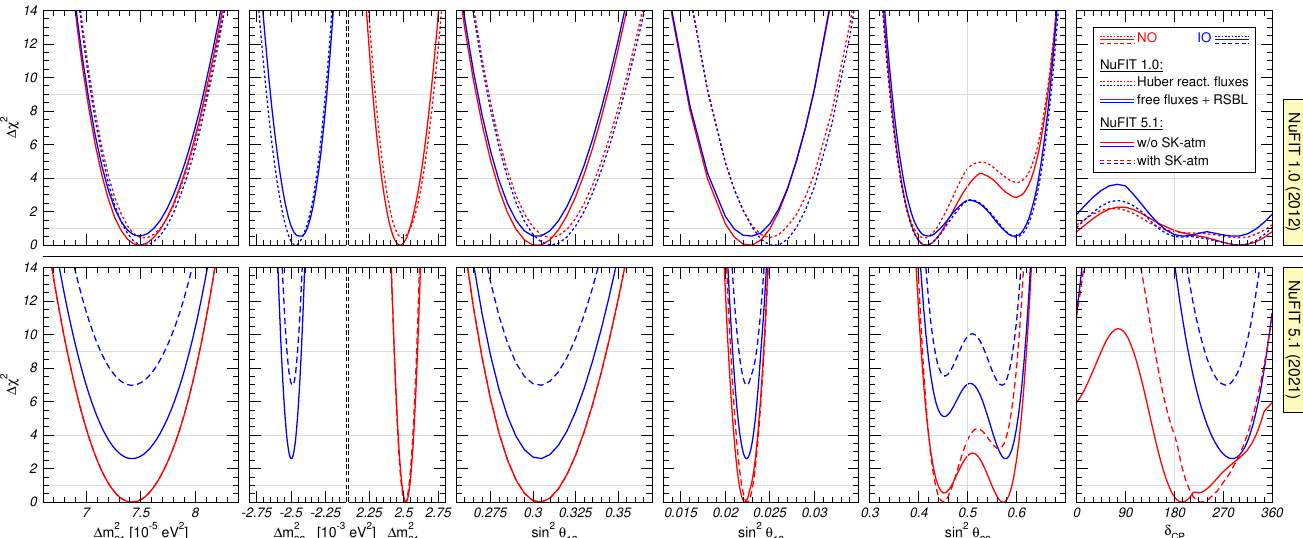
Figure 1. Comparison of global 3 ν oscillation analysis results. All panels show ∆ χ 2 profiles minimised with respect to all undisplayed parameters. Red (blue) curves are for normal (inverted) ordering. As atmospheric mass-squared splitting, we used ∆ m 2 for NO and ∆ m 2 for IO. ( top ) NuFIT 1.0 results. Solid curves obtained with free normalisation of reactor 32 31 fluxes and the inclusion of data from short-baseline (less than 100 m) reactor experiments; for dotted curves, short-baseline data were not included, but reactor fluxes were fixed to the predictions of [40]. ( bottom ) NuFIT 5.1 results. In all curves, theneutrino fluxes for each reactor experiment were constrained by the corresponding near detector. Solid (dashed) curves obtained without (with) including tabulated SK-atm ∆ χ 2 data. Figure adapted from